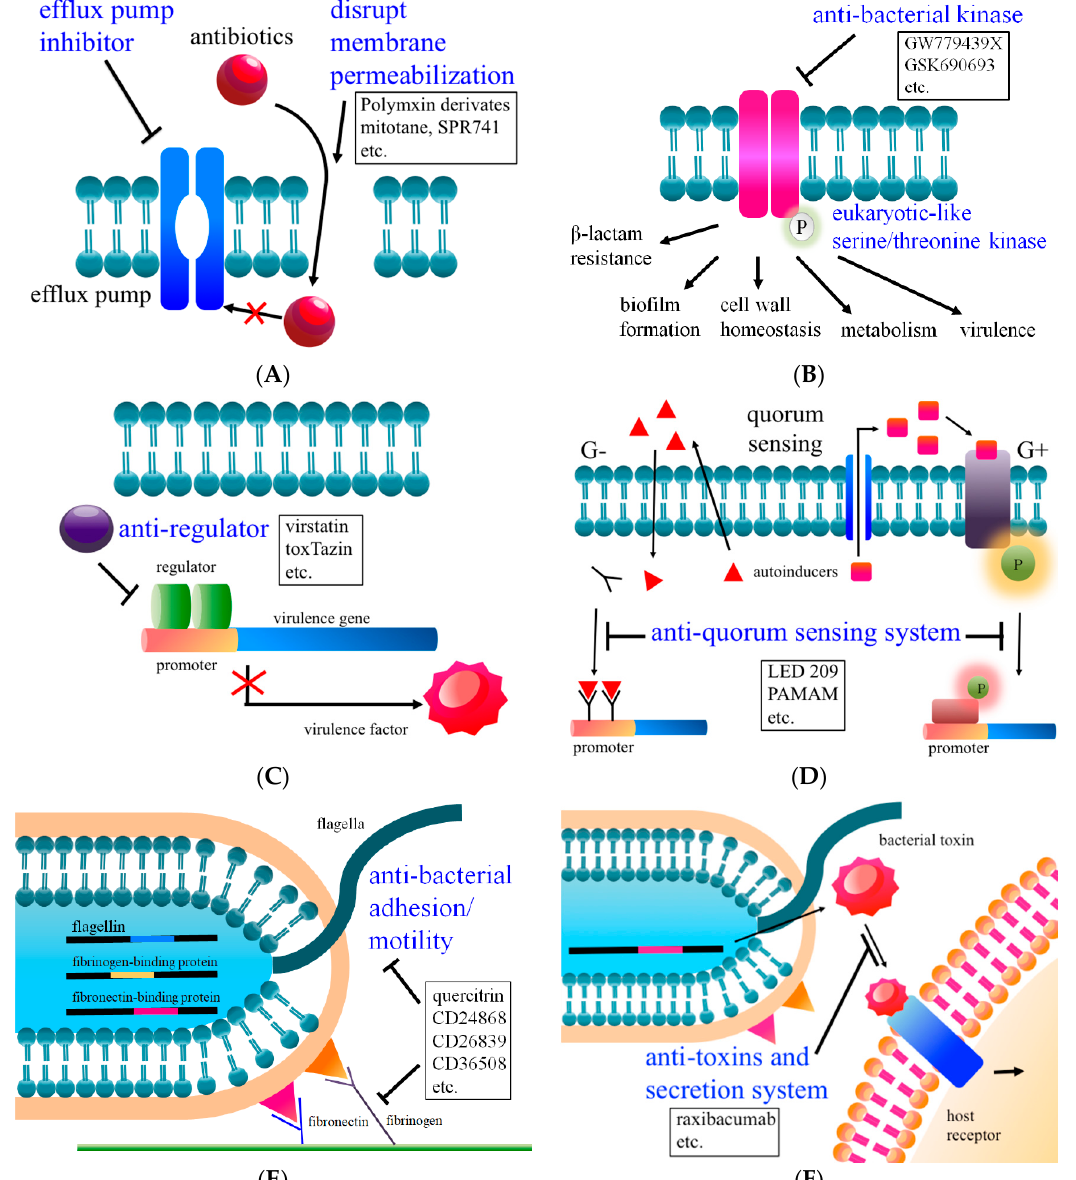
Figure 1. Illustration of alternative antibacterial therapies: ( A ) increase membrane permeability, ( B ) inhibit kinase activity and intrinsic resistance, ( C ) anti-regulators, ( D ) anti-quorum sensing system, ( E ) reduce adhesion and motility, and ( F ) anti-toxins and secretion system.